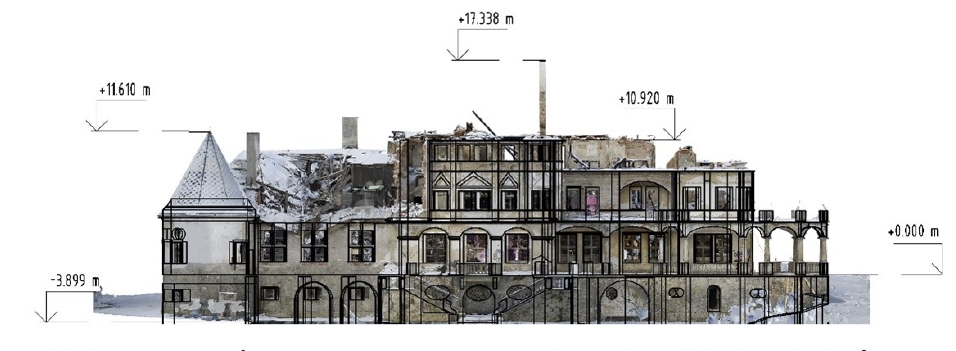
Figure 13. West view of the researched object.